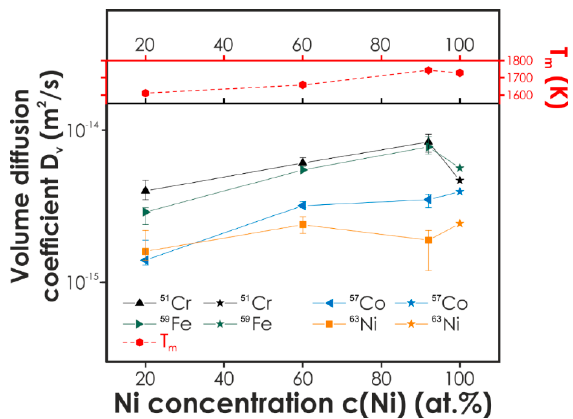
Figure 21. Volume diffusion coefficients determined for the Co 20 Cr 20 Fe 20 Mn 20 Ni 20 , Co 10 Cr 10 Fe 10 Mn 10 Ni 60 , and Co 2 Cr 2 Fe 2 Mn 2 Ni 92 alloys, as functions of Ni content. The melting points are also presented. Data for pure Ni is given for comparison (after [41]). Reprinted from Scripta Materialia 159 (2018), Transition from a dilute solid solution to a high entropy alloy, 94–98, Copyright 2018, with permission from Elsevier.